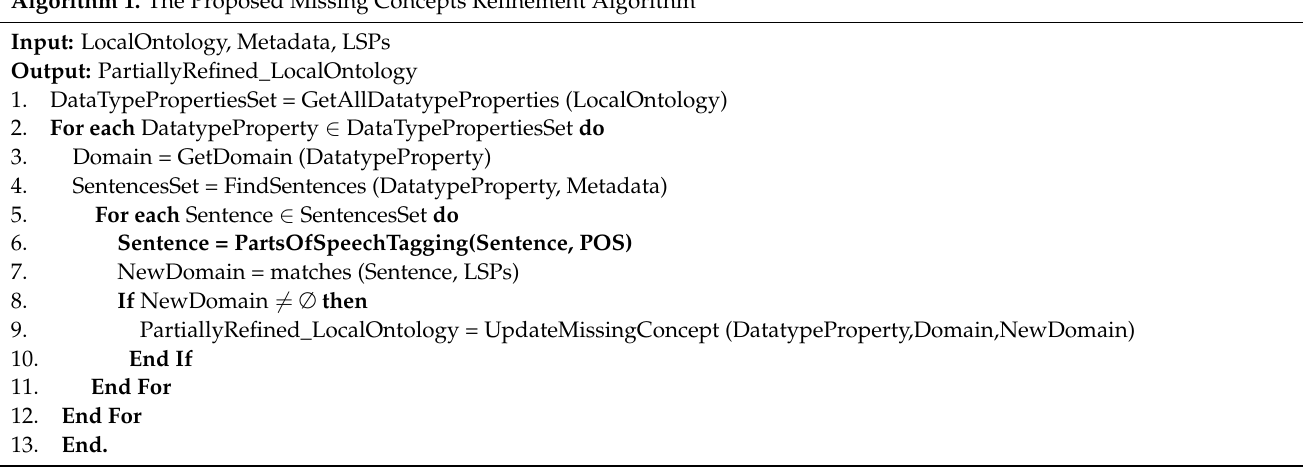
Algorithm 1. The Proposed Missing Concepts Refinement Algorithm